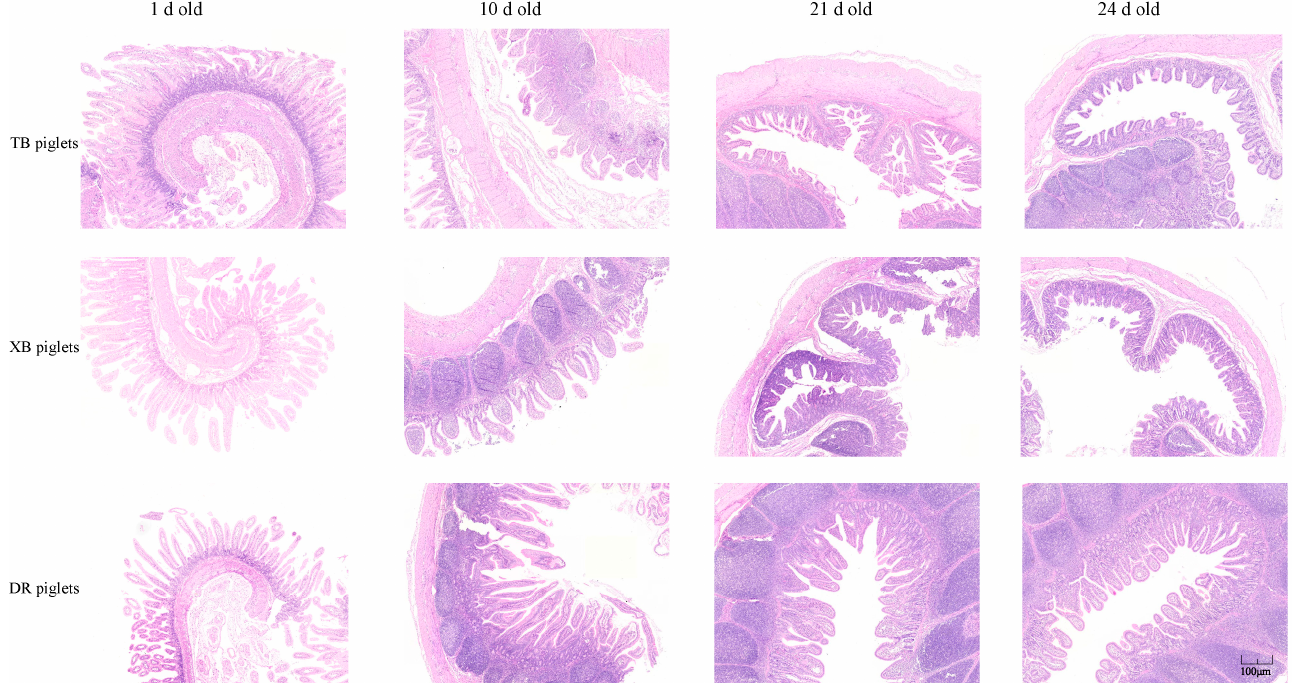
Figure 2. Comparison of ileal histological appearance of three breeds of piglets at different ages ( n = 10). Sections were stained by hematoxylin and eosin. TB piglets, Taoyuan black piglets; XB piglets, Xiangcun black piglets; DR piglets, Duroc piglets. Scale bars, 40 ×. Table 5. Differences in the ileal morphology of piglets at different ages.